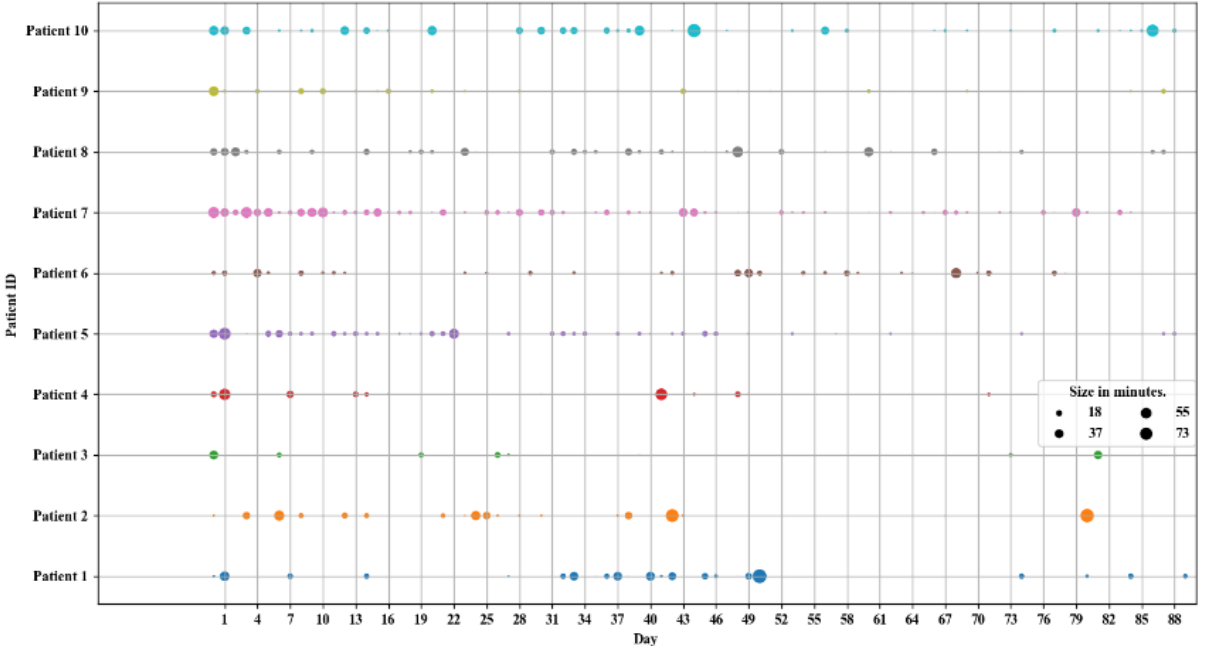
Figure 1. Individual patterns of engagement at a daily level. Usage is displayed as an aggregated sum of total minutes per